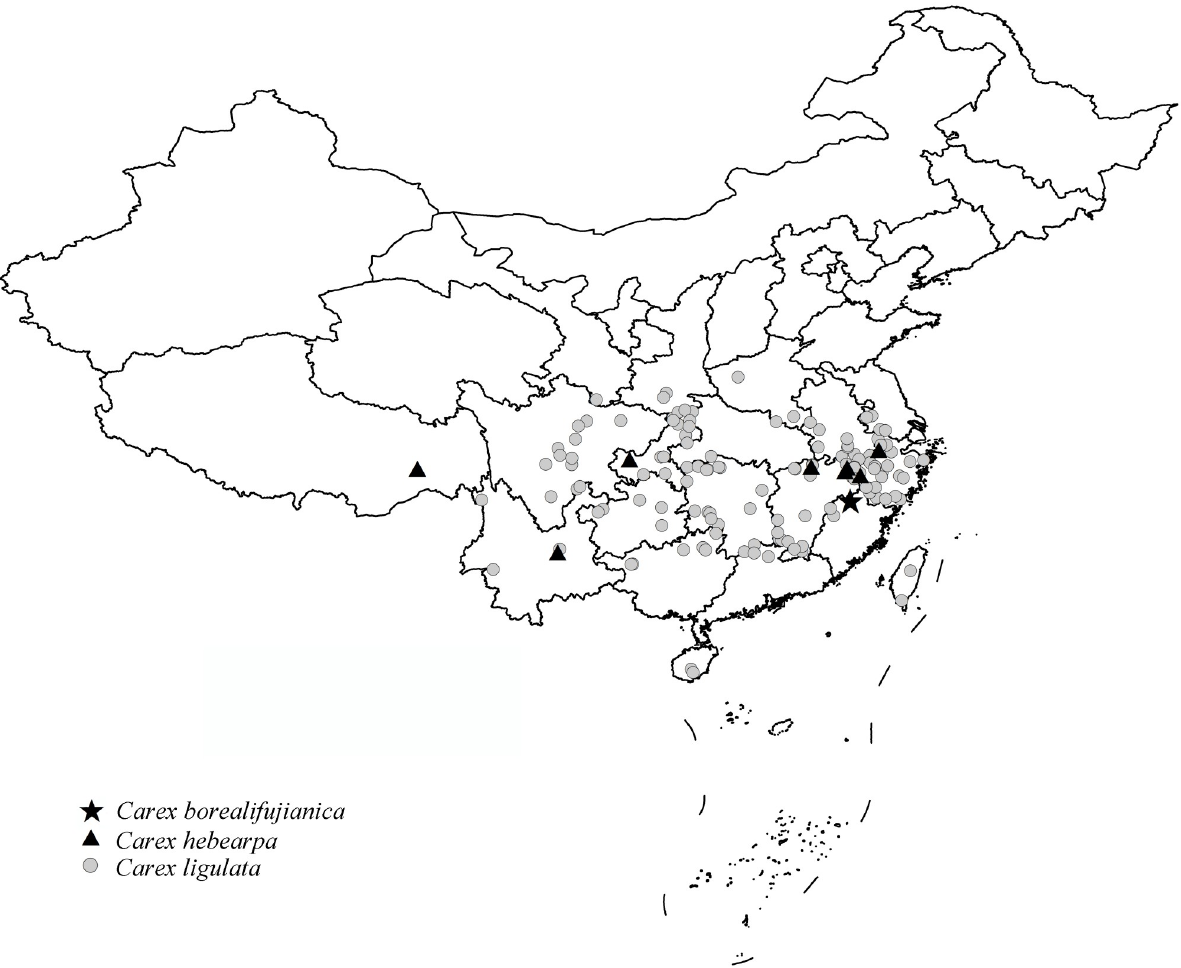
Fig 6. Distribution map of Carex borealifujianica , C . hebecarpa and C . ligulata . (Map source: https://www.webmap.cn/main.do?method=index; the distribution information is from collection notes of the specimens stored in ANUB, CDBI, HHBG, HNWP, HTC, IBK, KUN, LBG, NAS, PE, SZ, WUK and